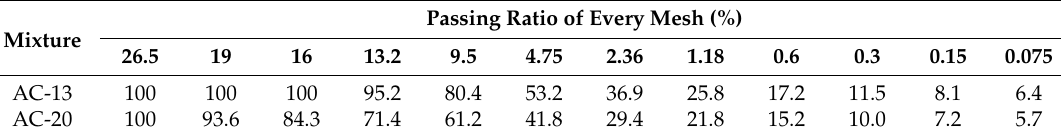
Table 7. Aggregate gradation of AC-13 and AC-20 mixtures.